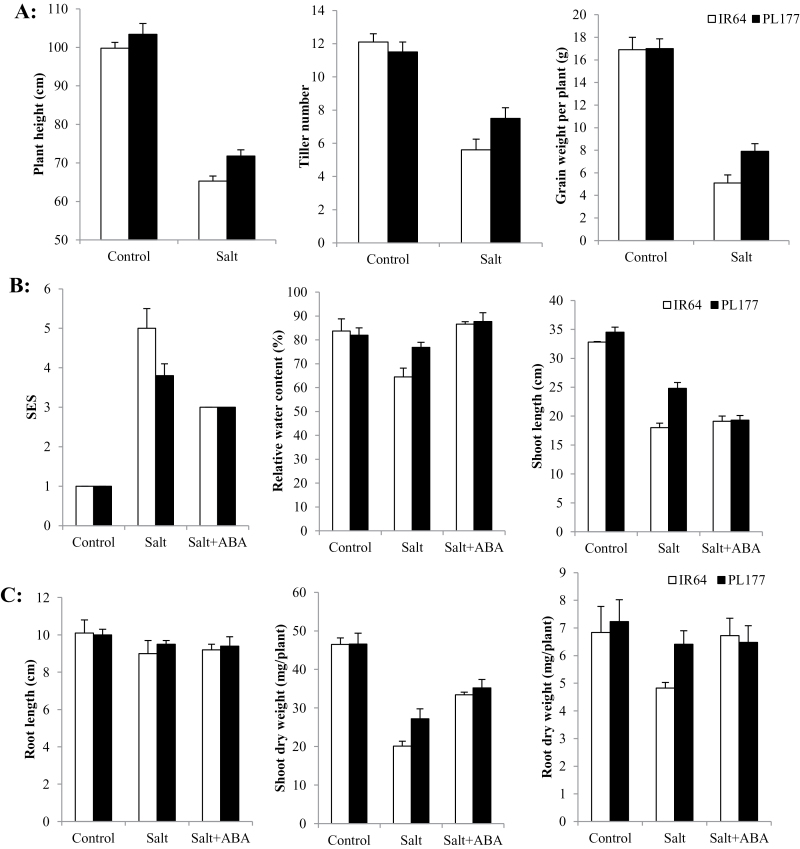
Morphological and yield trait performance of IR64 and PL177 measured under control, salt, and/or salt+ABA conditions. Results are shown as means±SD.